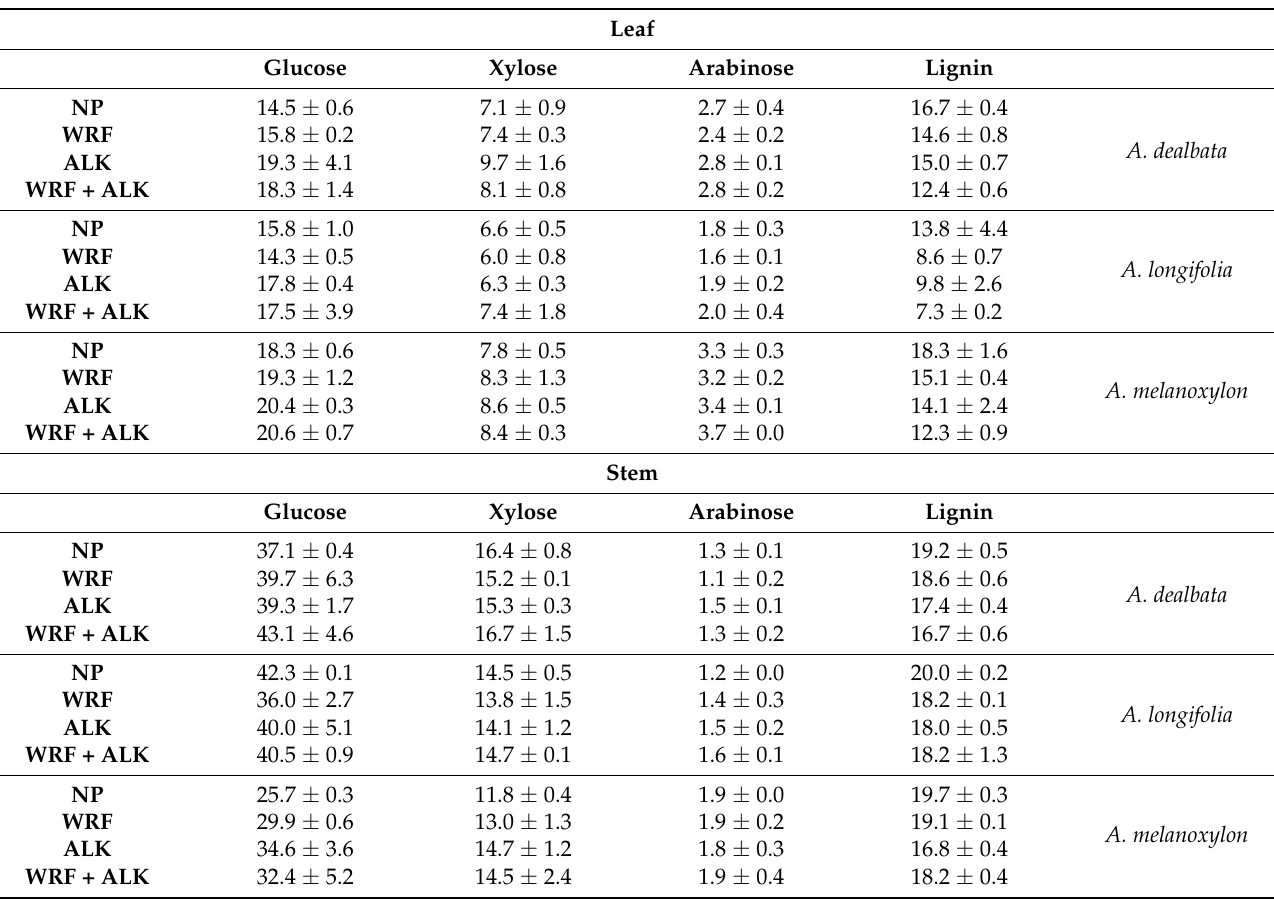
Table 3. Mean percentage (%) composition of alcohol insoluble residues (AIR) prepared from pre- treated biomass from three Acacia spp. Pretreatment acronyms: NP, non-pretreated control samples; WRF, samples pretreated with Pleurotus ostreatus ; ALK, alkali-pretreated samples; WRF + ALK, sam- ples pretreated with P . ostreatus followed by the alkali pretreatment. Values are the mean ± standard error of the sample replicates. Leaf